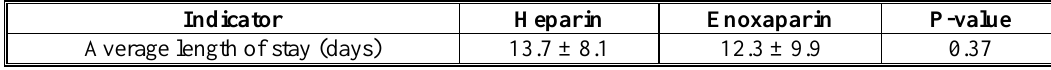
Table 5. Average length of stay in hospital (days) for patients with COVID-19 infection who received Anticoagulants therapies (Heparin and Enoxaparin).